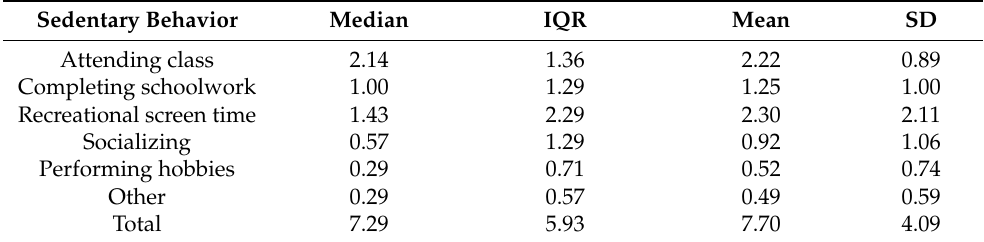
Table 2. Sedentary time of participants (hours per